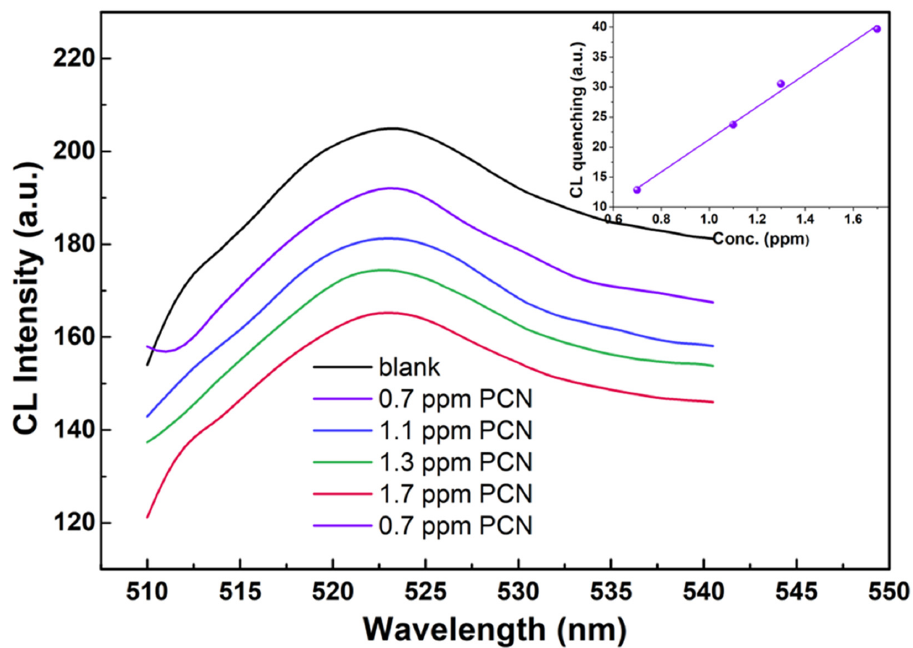
Figure 7. Chemiluminescence spectra of G-APTMS@ZnO as a function of penconazole (PNC) con- centration. The peak intensity variation is reported in the inset as a function of the concentration, indicating a good linear response. The LOD was evaluated as the concentration corresponding to three times the standard deviation of the signal in the blank sample and it was found to be 0.1 ± 0.01 ppm. This value is in line with LODs found for the detection of OCPs by SERS (detection of penconazole using this technique has not been reported so far, and we made a com- parison with other OCPs), and higher than for HPLC detection of penconazole (Table 6).